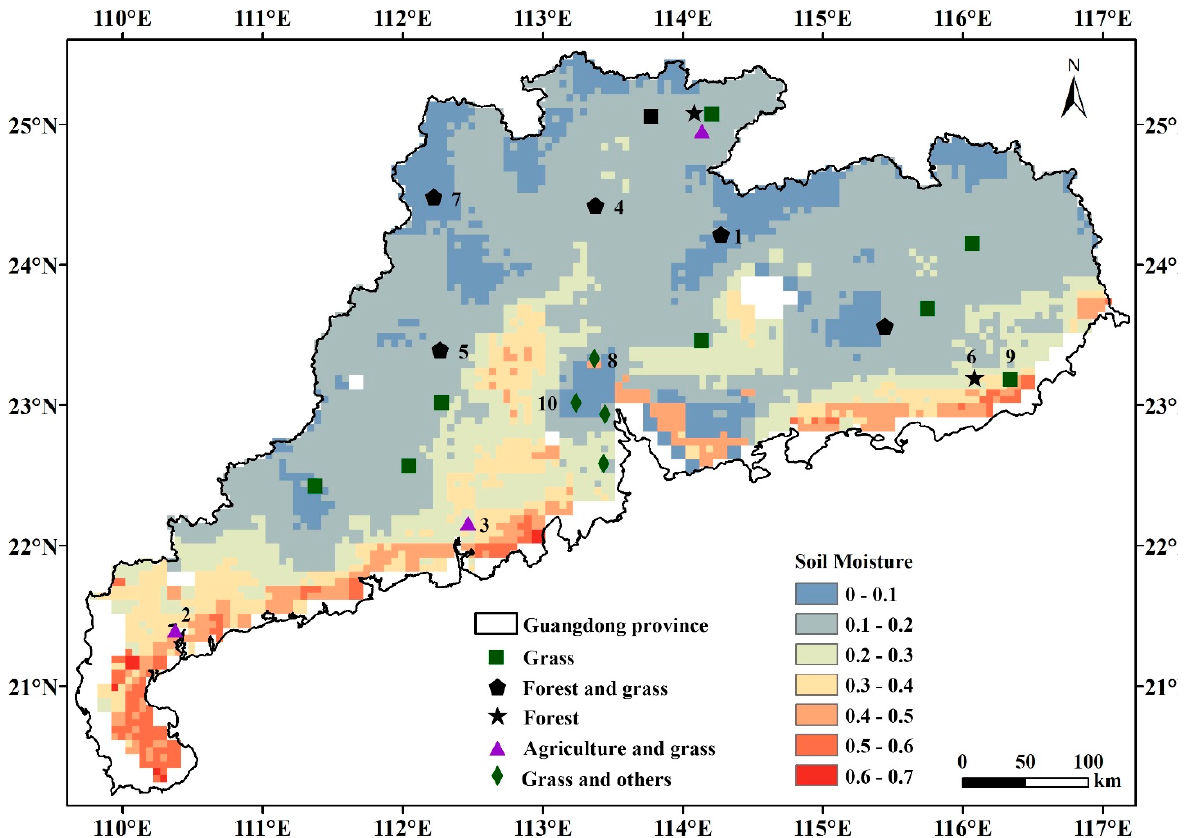
Figure 3. The spatial distribution of average soil moisture of Guangdong. Different styles of points represent different main use/land cover types within 5 × 5 pixels of the stations.